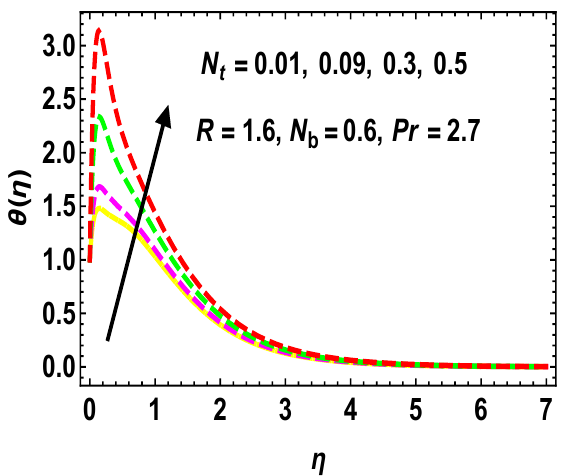
Figure 12. Outcomes of φ ( η ) for N b where yellow, magenta, green, and red lines represent for N b = 0.1, N b = 0.2, N b = 0.3, and N b = 0.4 respectively.